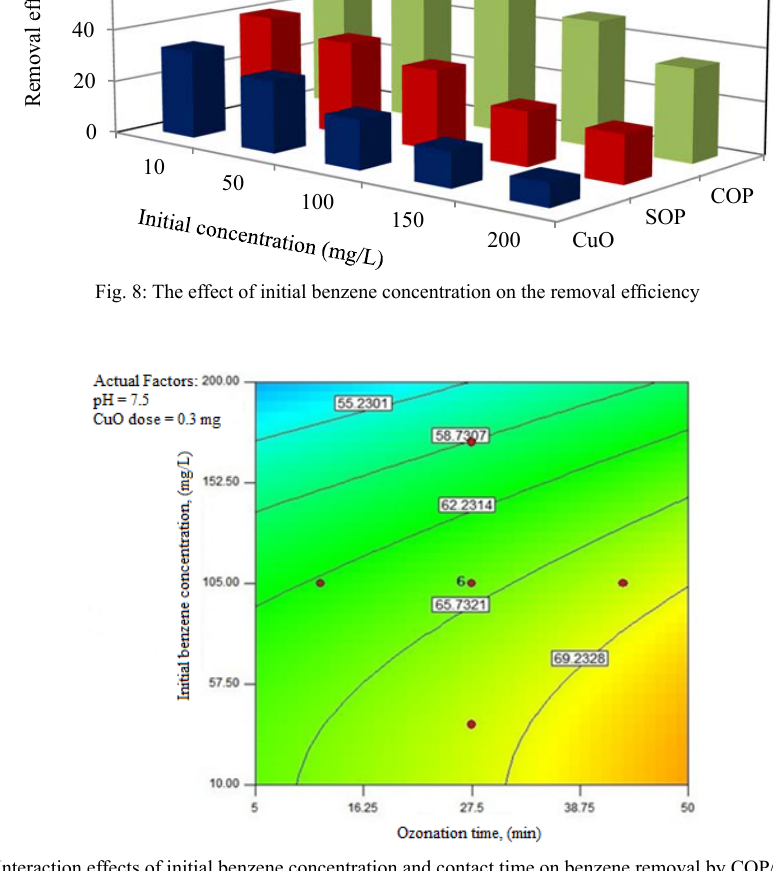
Fig. 9: Interaction effects of initial benzene concentration and contact time on benzene removal by COP/CuO-NPs